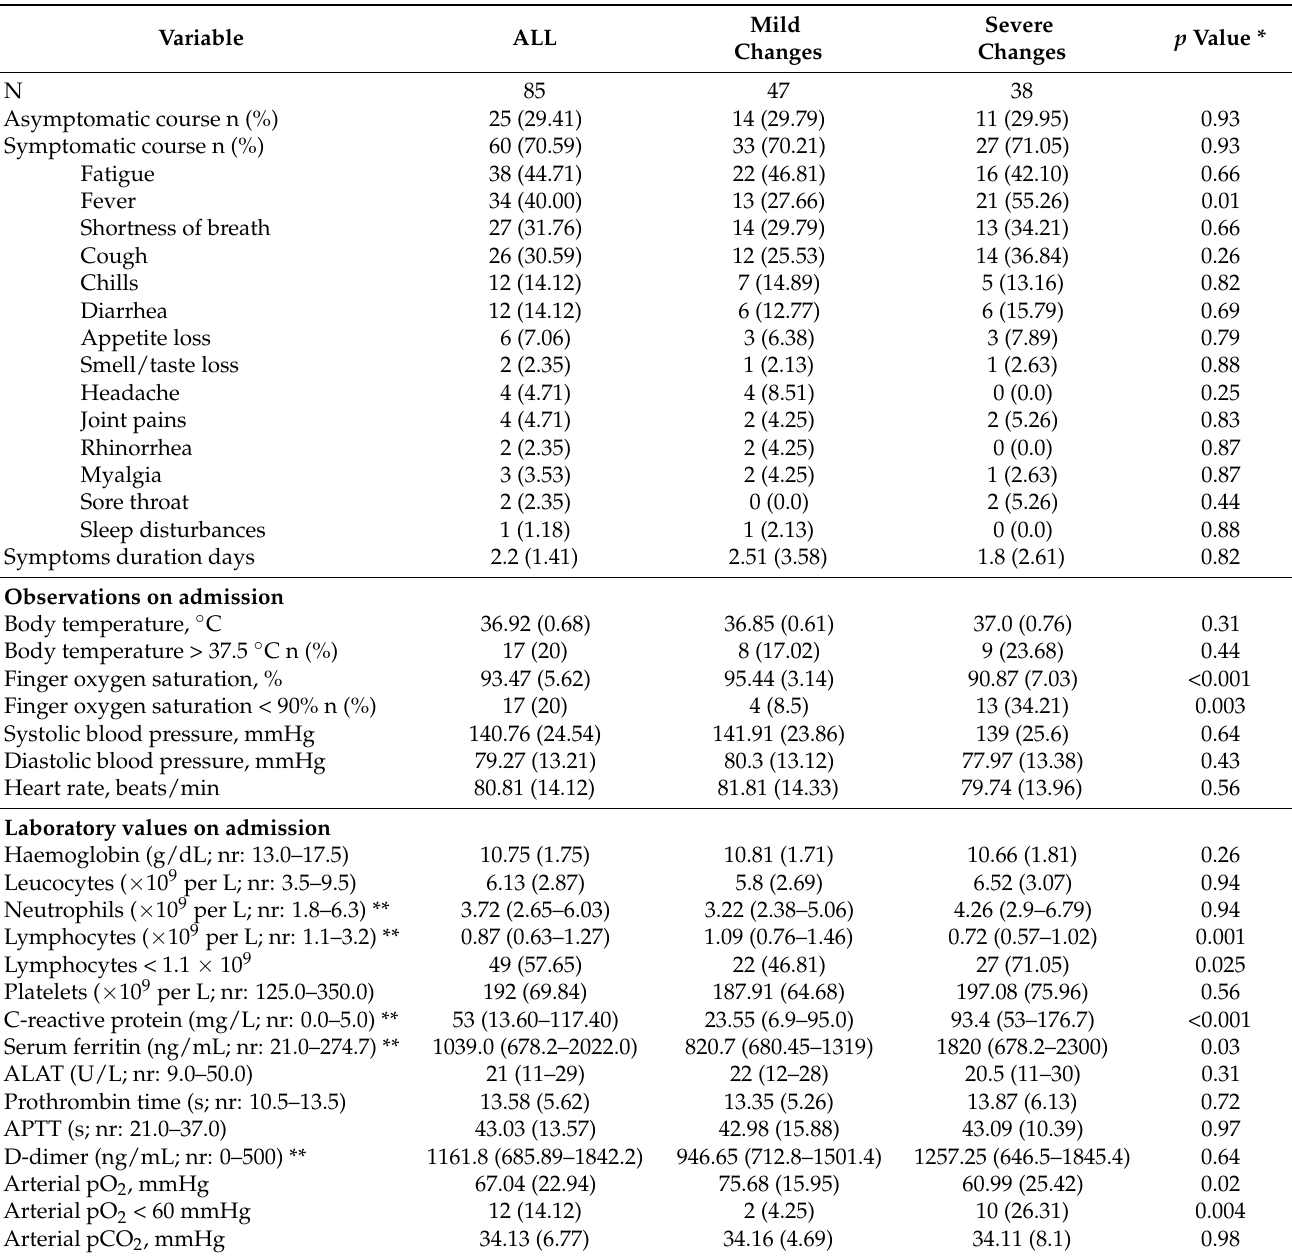
Table 2. Clinical presentation on admission to the